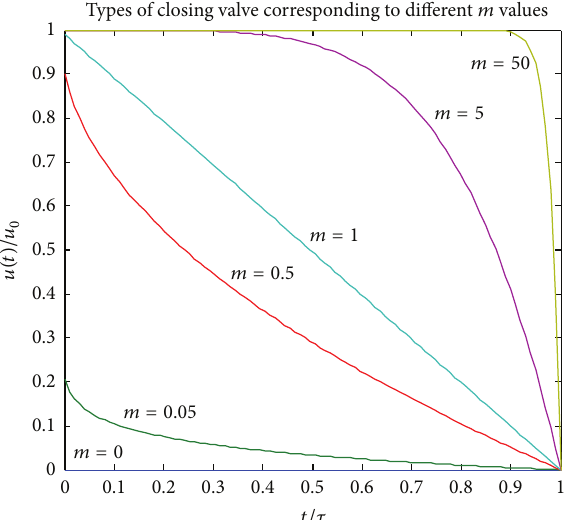
Figure 3: Closing function corresponding to different values of 𝑚 (from (20a)).